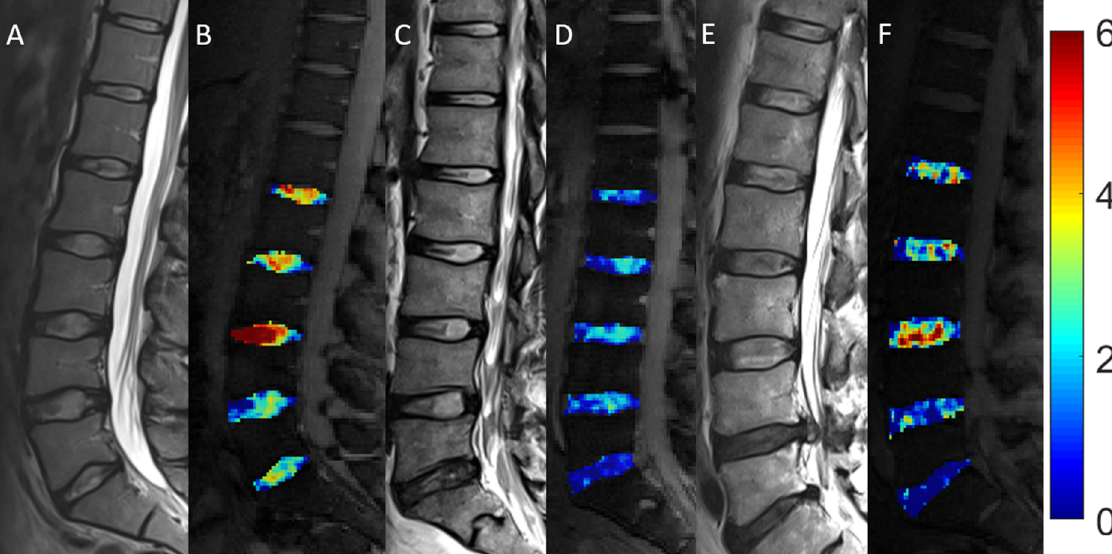
Figure 1. Morphologic and compositional imaging findings of lumbar intervertebral discs of an asymptomatic volunteer ( A , B ), a patient with nonspecific low back pain ( C , D ), and a patient with radiculopathy ( E , F ). A, C and E: Sagittal T2- weighted (T2w) images show the absence of morphologic signs of relevant IVD degeneration ( A ), substantial dehydration at the L4/L5 segment ( C ) and the L5/S1 segment ( C , E ) accompanied by extrusion at the L4/L5 segment ( E ). B, D and F: Sagittal glycosaminoglycan Chemical Exchange Saturation Transfer (gagCEST) images with overlaid color-coded maps to visualize the GAG contents of the IVD segments. Low GAG content is depicted in blue, and high GAG content is depicted in red. The unit of scale on the right is gagCEST effect in %. The lowest values are found in the patient with nsLBP, while the highest values are seen in the asymptomatic volunteer.